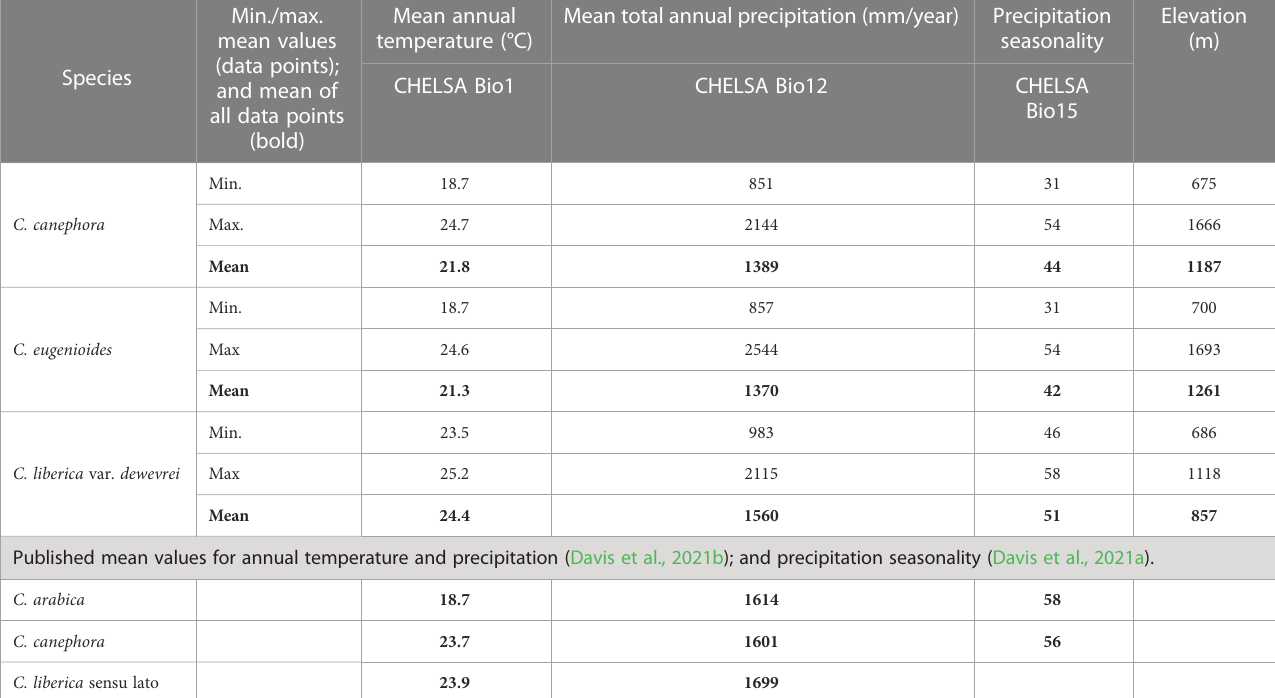
TABLE 1 Basic climate pro fi ling and elevations for three indigenous Ugandan coffee species, based on location records for Ugandan distributions, with comparative data from published sources. Min./max. Mean annual mean values temperature (°C) (data points); Species and mean of all data points (bold)